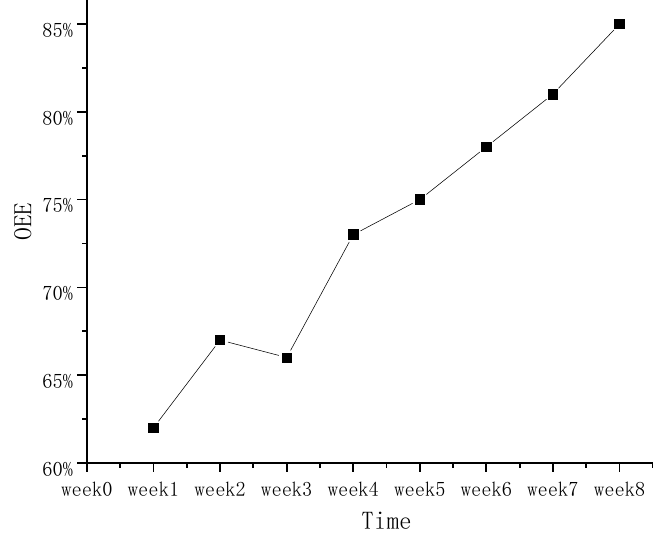
Figure 14. The weekly average daily OEE.